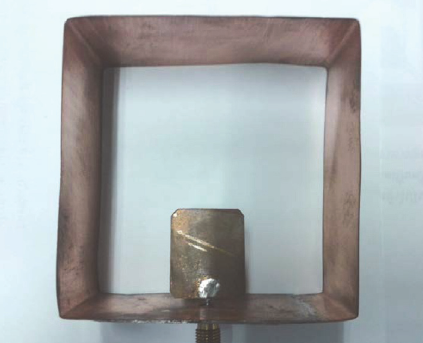
Figure 13: Photograph of a prototype antenna.